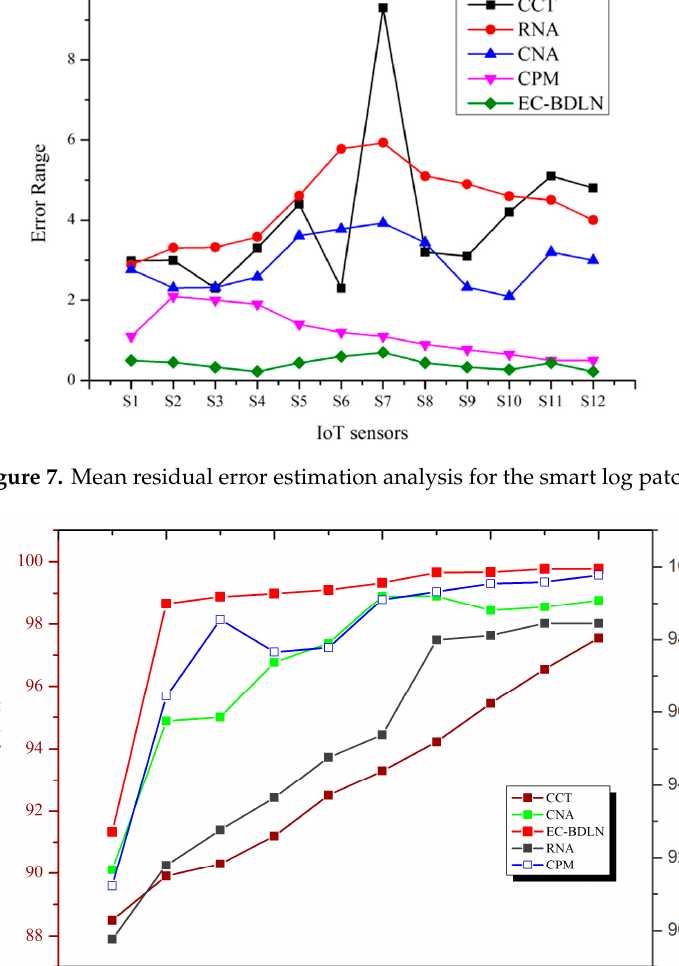
Figure 7. Mean residual error estimation analysis for the smart log patch.